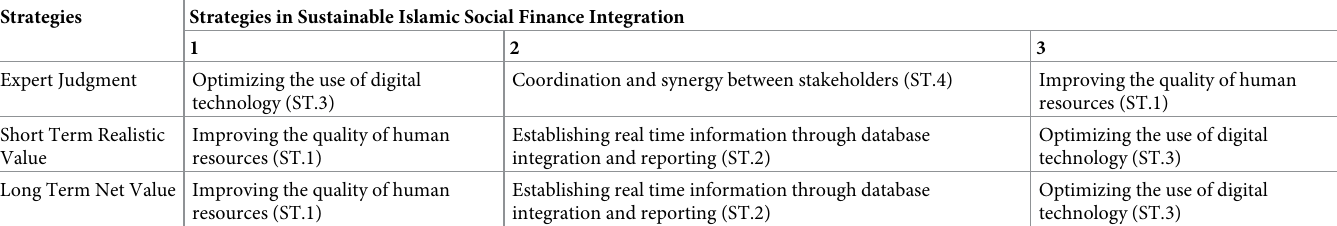
Coordination and synergy between stakeholders (ST.4) Improving the quality of human